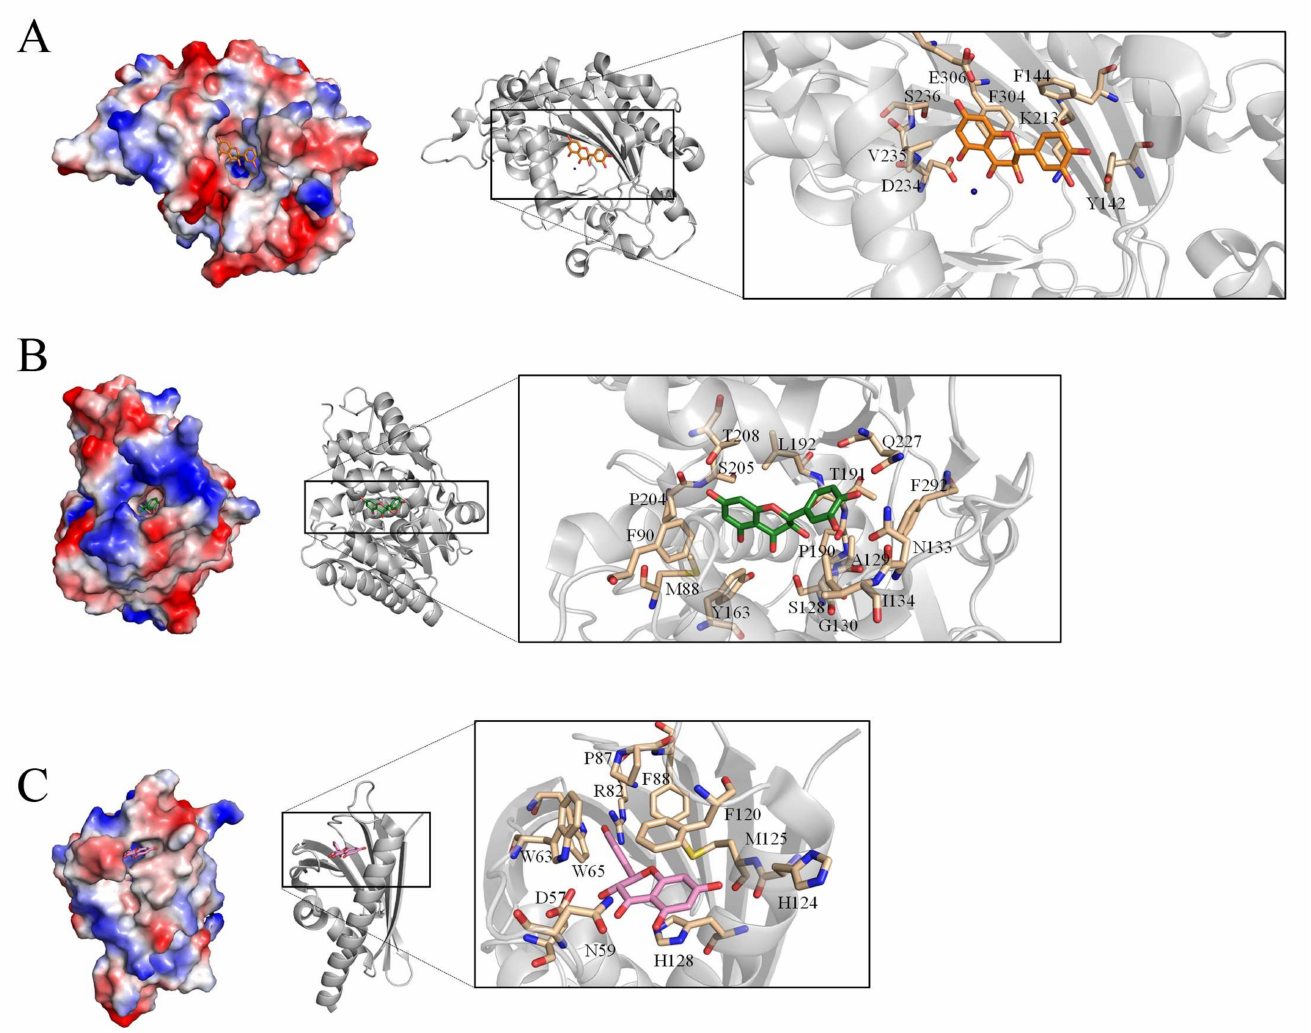
Figure 6. The taxifolin structural interactome. Three taxifolin-complexed protein structures are available in the PDB: ( A ) anthocyanidin synthase (PDB ID 1GP5), ( B ) dihydroflavonol reductase (PDB ID 2C29), and ( C ) WhiE aromatase/cyclase (PDB ID 3TVQ). Although these enzymes are all involved in the biosynthesis of flavonoids, their taxifolin-binding modes are significantly